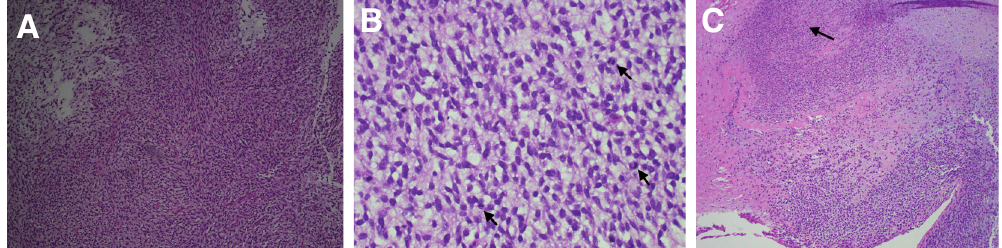
Figure 3. Biopsy specimen with routine hematoxylin-eosin stain. ( 3a ) (× 100 magnification) shows cellular monophasic tumor with spindle cells in fascicular growth pattern. ( 3b ) (× 400 magnification) shows cells in a myxoid background with many mitosis (arrows). ( 3c ) (× 100 magnification) shows large areas of necrosis (arrow).